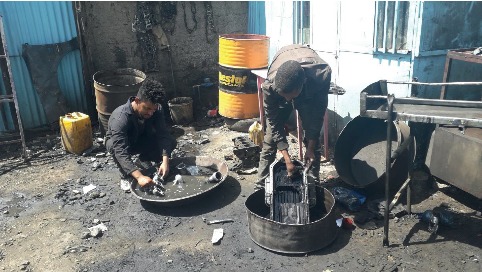
Vehicle repair workers bending and squatting to clean parts.